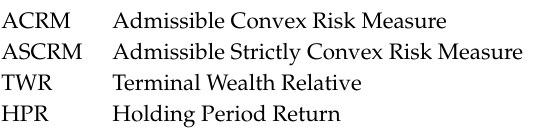
1 (cid:62) for Example 2 ) T = , 1 , ϕ ∗ 2 1 5 5 (cid:17) (cid:16)